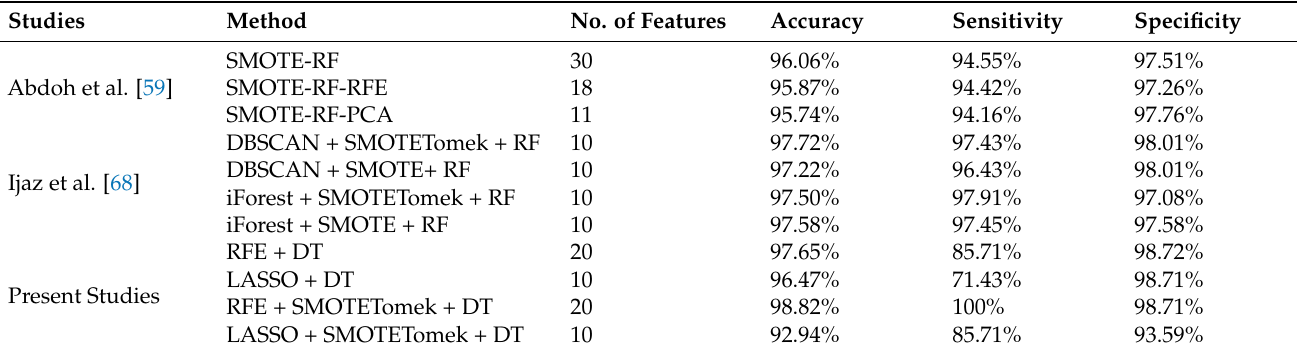
Table 7. Comparison of biopsy test results of our model with past studies.